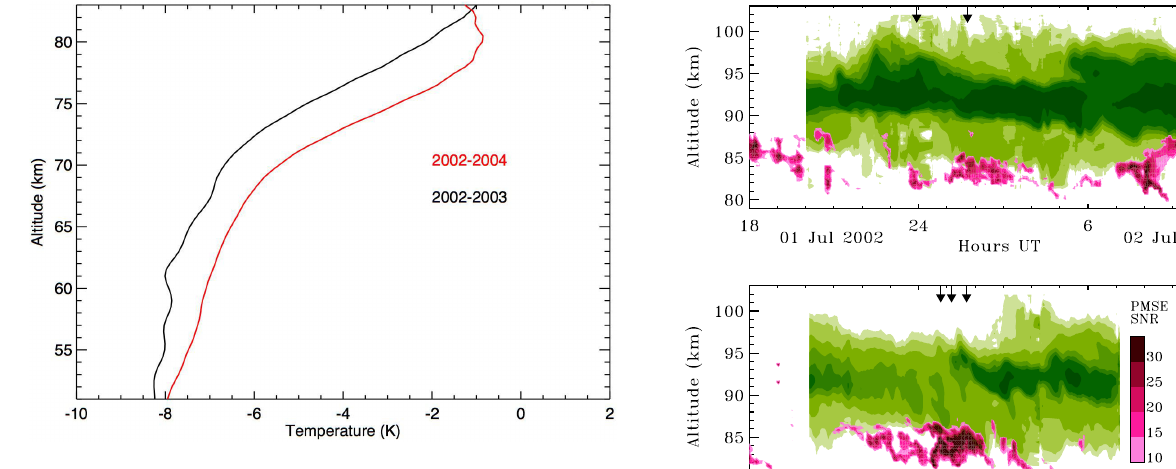
Fig. 9. Mean difference profiles of temperature measured by the SABER instrument aboard the TIMED satellite for 2002–2003 (black) and 2002–2004 (red) for the time period 15 June–15 July at 69–70 ◦ N. Both demonstrate the cooler than normal atmosphere below 80km during 2002.